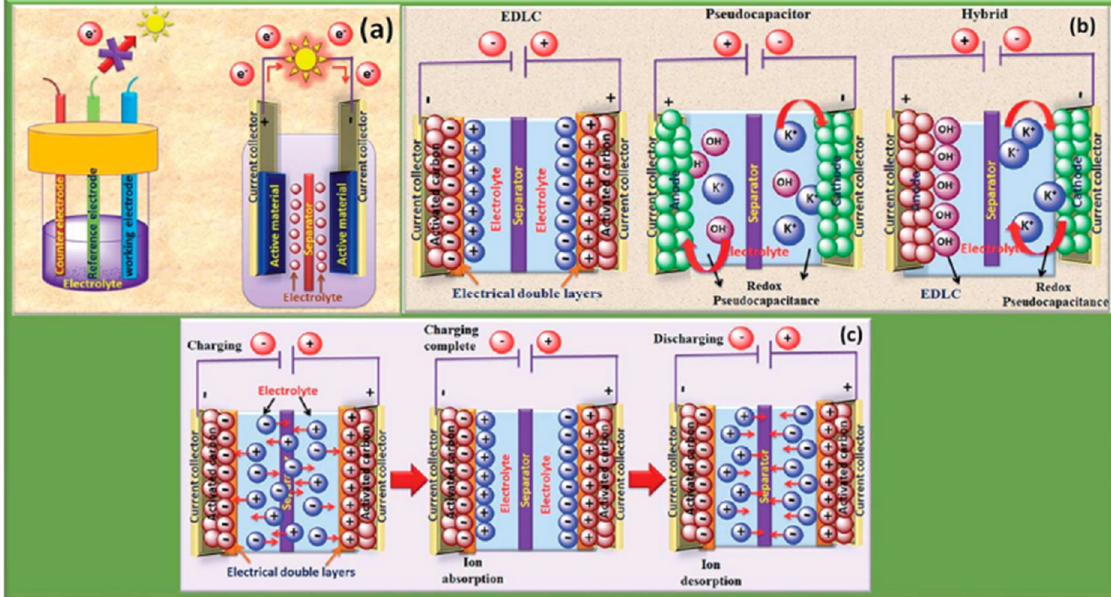
Figure 4. ( a ) Schematic representation of the two-electrode system and three-electrode system. ( b ) Supercapacitors types. ( c ) Mechanism during charge storing. Reprinted with permission from ref. [94]. Copyright 2019 Royal Society of Chemistry.